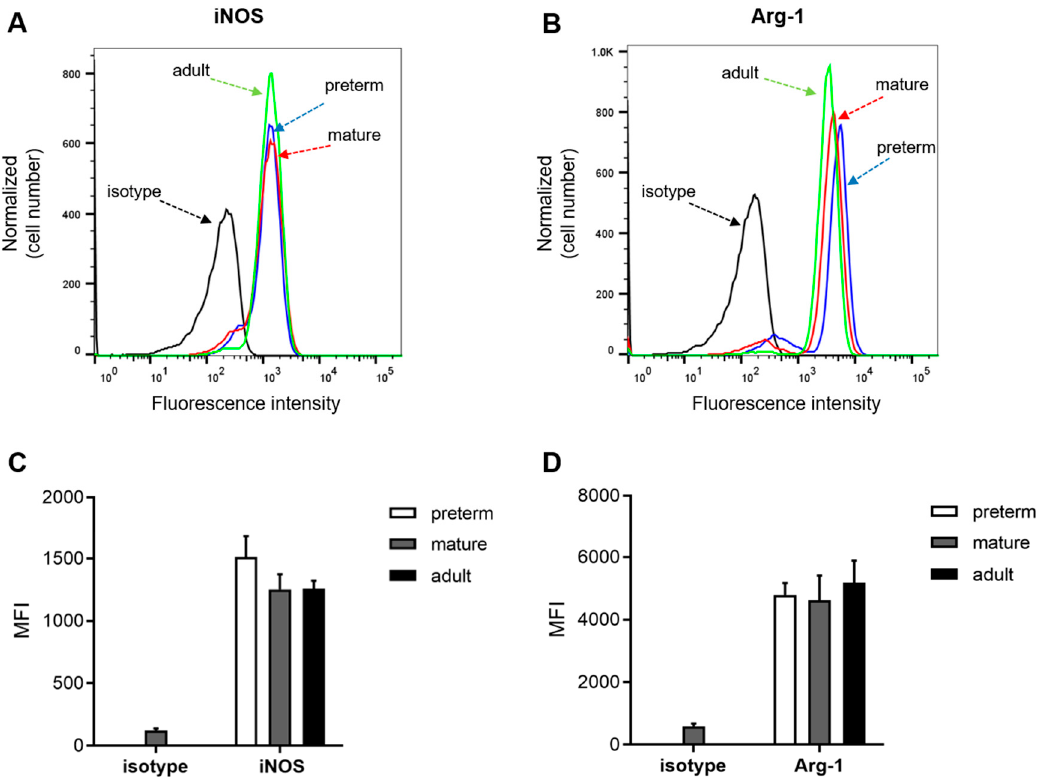
Figure 5. Expression of Arginase 1 (Arg-1) and inducible nitric oxide synthase (iNOS) is not ontogenetically regulated. Expression of Arg-1 and iNOS on peripheral polymorphonuclear leukocytes (PMNs) were compared by flow cytometry. Representative histograms are shown for both Arg-1 ( A ) and iNOS ( B ). Quantification of mean fluorescence intensity (MFI) is shown for both Arg-1 ( C ) and iNOS ( D ). Data presented as mean + SEM from at least 5 separate experiments. No statistical differences were found by one-way ANOVA with Tukey’s post hoc analysis. Significance was set at p < 0.05.